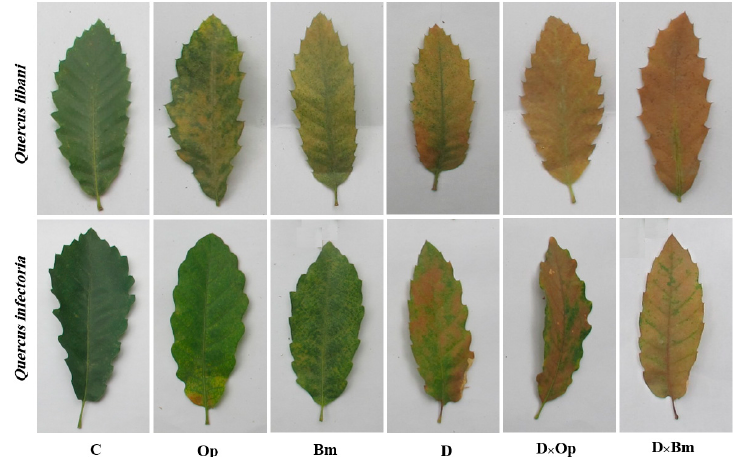
Figure 2. Discoloration of Quercus libani and Q. infectoria leaves affected by charcoal disease, drought and their interaction. Op: Obolarina persica , Bm: Biscogniauxia mediterranea , D: Drought, D × Op: Drought × O. persica and D × Bm: Drought × B. mediterranea .